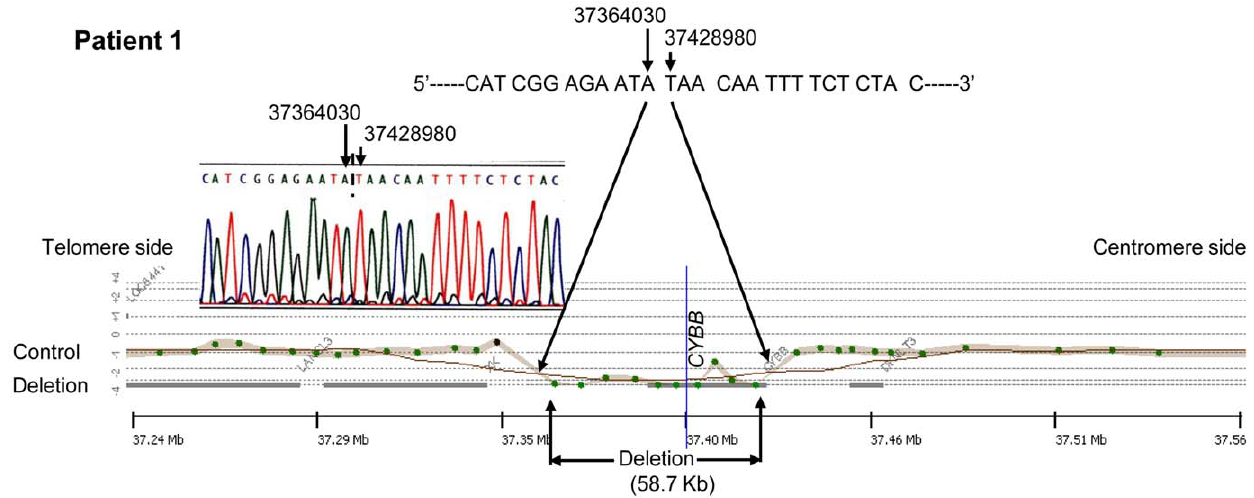
Figure 2. The Results of aCGH and Direct Sequence Analysis Spanning the Deletion Breakpoints in Patient 1. A female’s DNA was used for the control DNA. aCGH analysis showed the deletion region to be 58.7 kb and direct sequencing after amplification by PCR showed that genes had been deleted from 37364030 to 37428980 (UCSC hg17 May.2004) and both breakpoints were bound.